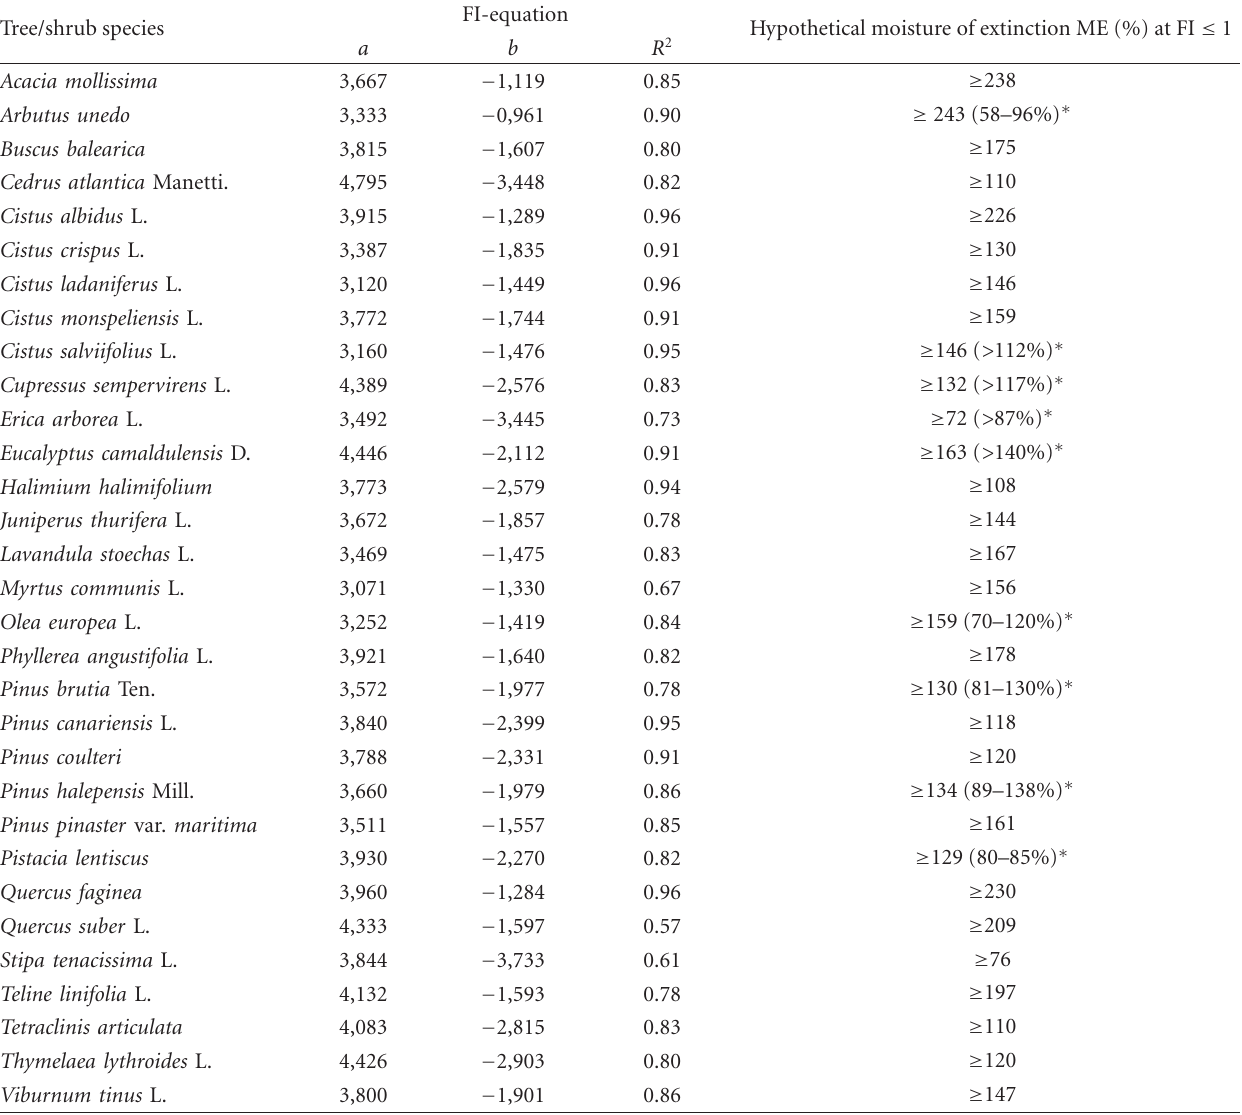
Table 5: Regression coe ffi cient characteristics of the flammability index (FI) equations determined for Moroccan species as a function of the moisture content H (in absolute value), (FI = a + b H), and their hypothetical moisture of extinction ME (in %) at FI ≤